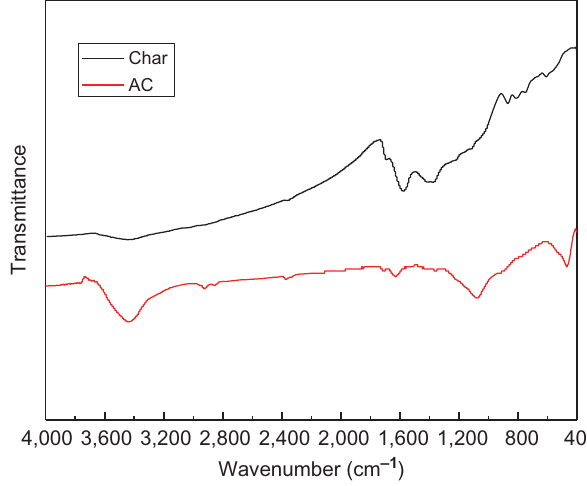
Figure 7: Fourier transform infrared spectroscopy (FTIR) spectra of the AC and char.